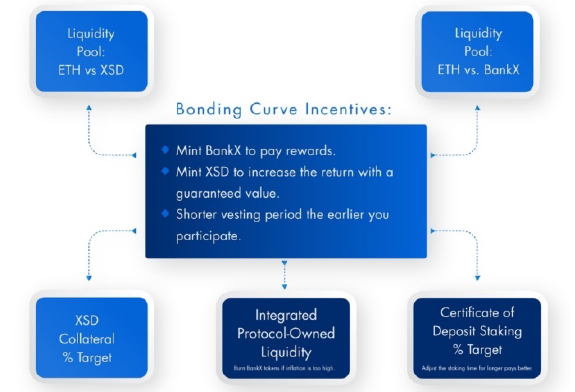
Figure 5. Listing different mechanisms, each one functioning as a deflationary/inflationary dynamic. Source: